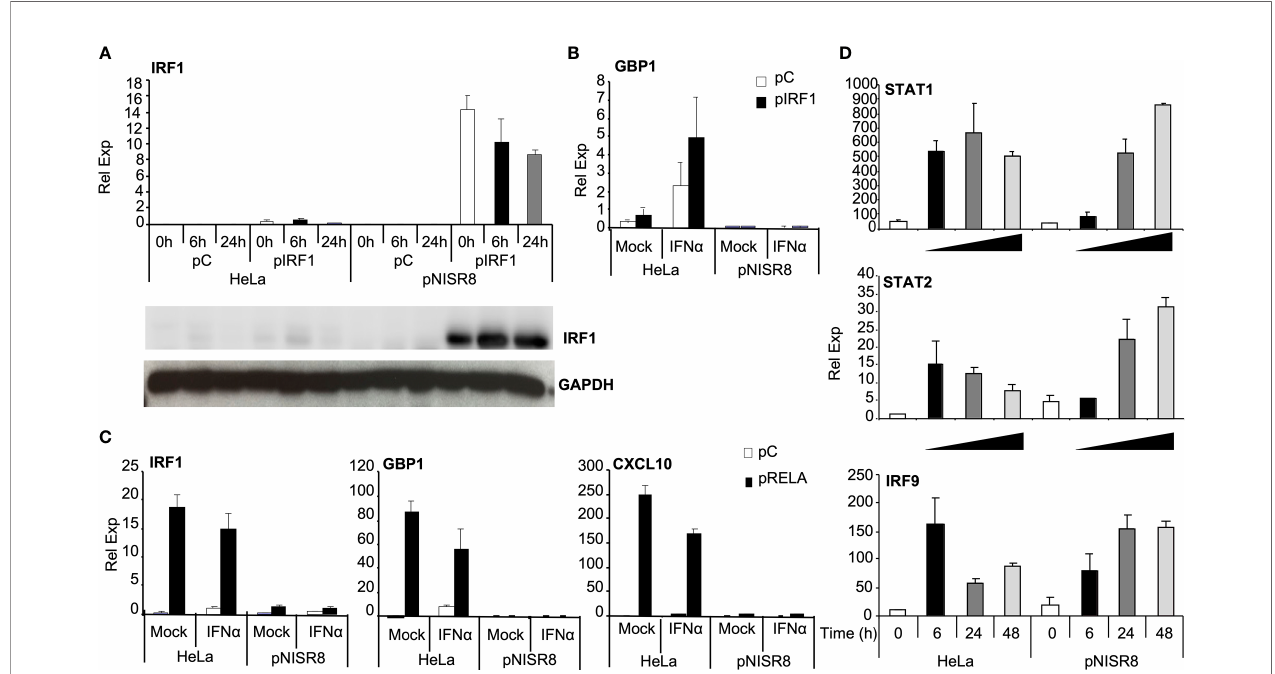
FIGURE 4 | Analysis of the induction of ISGs and proin fl ammatory genes in ISR8 -disrupted cells after IRF1 or RELA overexpression and IFN a treatment. (A) IRF1 mRNA was evaluated by RT-qPCR and IRF1 was visualized by Western-blot using GAPDH as a reference in the indicated cells transfected with a control plasmid (pC) or pIRF1 and treated with 0 or 1000 U/ml IFN a for the indicated times. (B) GBP1 mRNA levels were evaluated in cells treated as in A but IFN a was evaluated only for 6h. (C) IRF1, GBP1 and CXCL10 mRNAs were evaluated in cells treated like in B but transfected with pRELA. (D) STAT1, STAT2 and IRF9 mRNAs in the indicated cells treated with 0 or 1000 U/ml IFN a for the indicated times. GAPDH mRNA was used as a reference. Error bars indicate standard deviations. Experiments were performed at least four times and a representative fi gure is